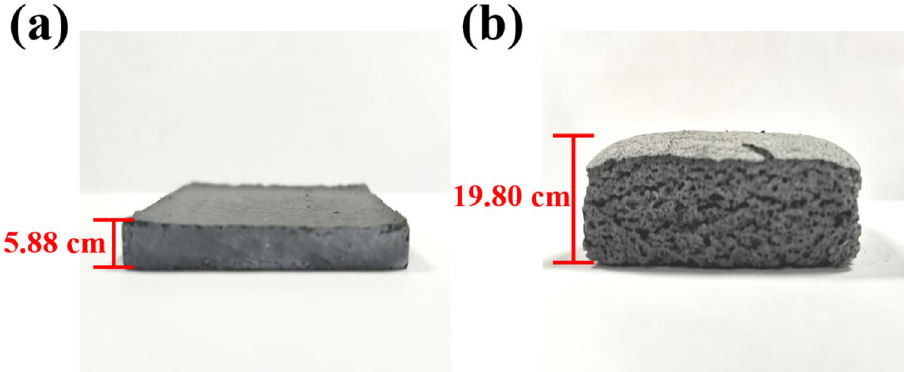
Figure 5. Contrast before and after foaming. ( a ) Before foaming; ( b ) After foaming.